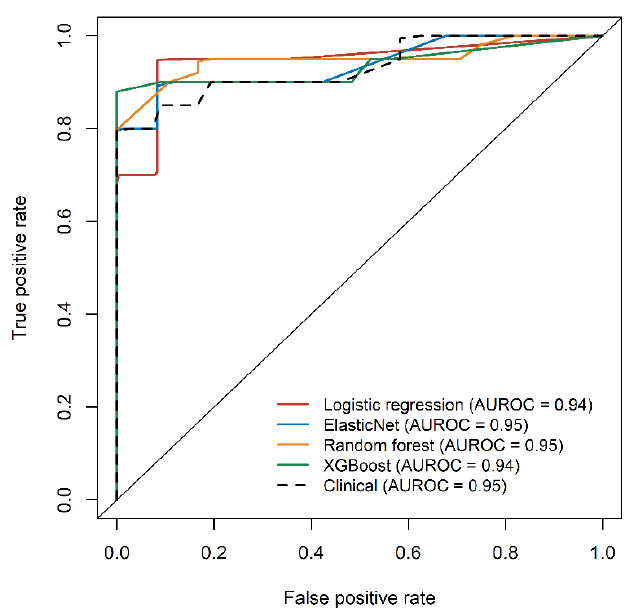
Figure 4. Receiver operating characteristic (ROC) analysis showed that NAFLD-specific metabolic features can be applied as important variables for NAFLD diagnostic model developed by machine learning approaches. The solid black line represents the line of unity. The area under the ROC curve (AUROC) values present the median values obtained from 100 repeated runs. Abbreviations: NAFLD, nonalcoholic fatty liver disease.